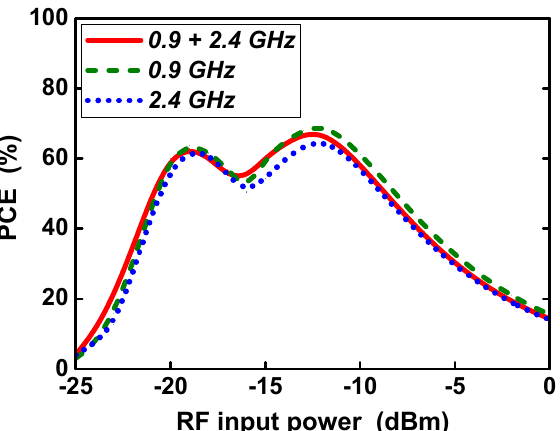
Figure 13. Reflection coefficient ( S 11 ) versus RF input frequency at different input powers.